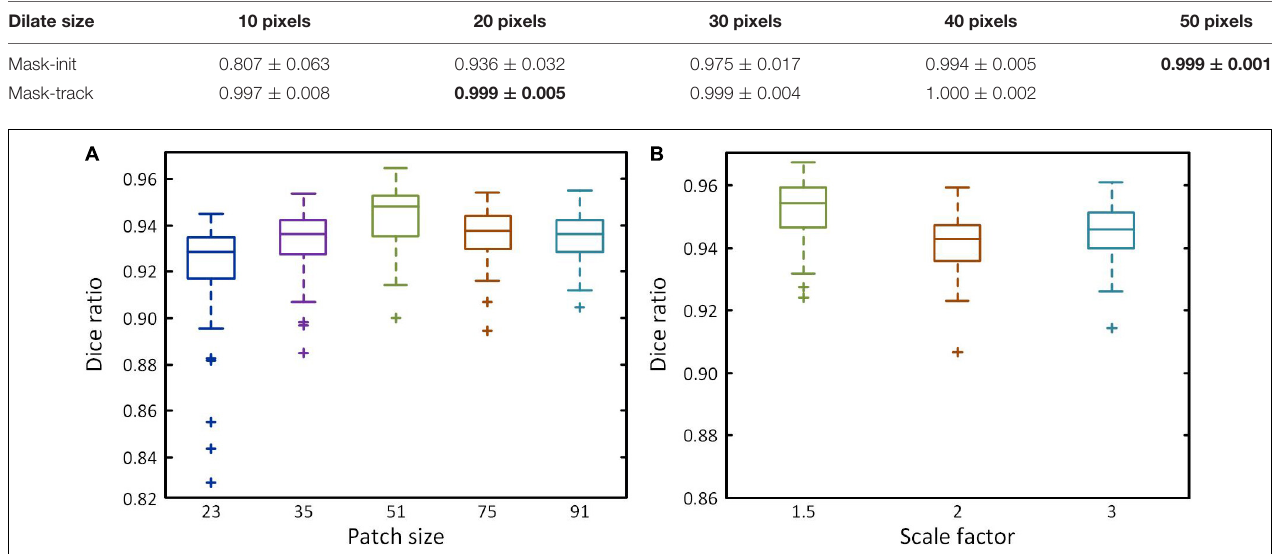
FIGURE 4 | Performance of different patch size. (A) Box plots showing the Dice ratio for five different patch sizes at a single scale. (B) Box plots showing the Dice ratio for the larger patch at different multiples of the smaller patch size.